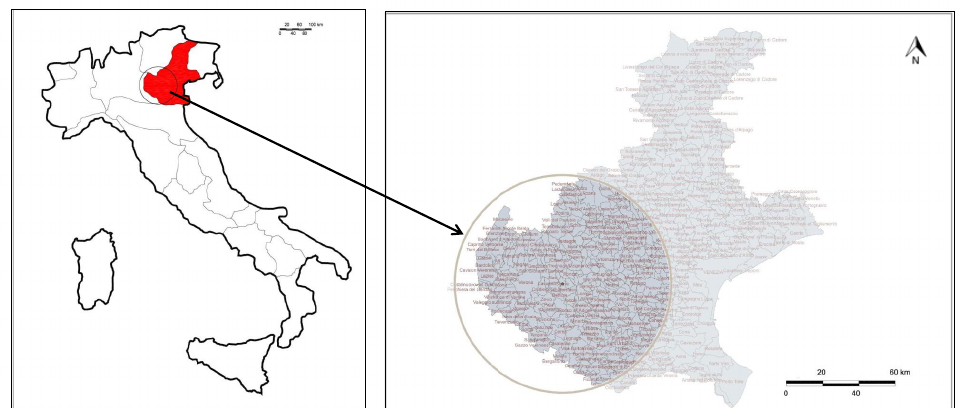
Figure 1. Map of the evaluated geographical area considered in this